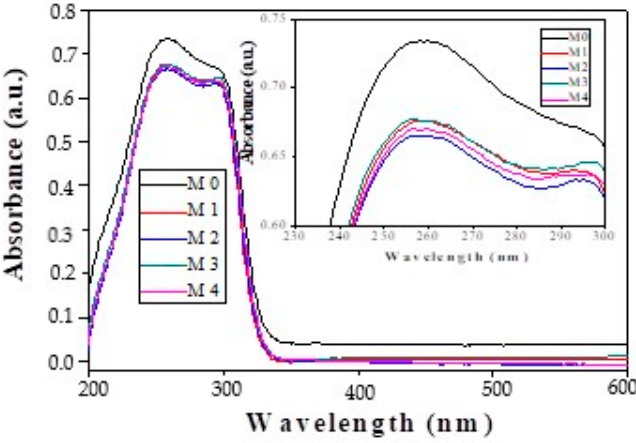
Figure 8. UV–VIS absorption spectrum of PPEES and nanocomposite membranes. The UV–VIS spectra show that PPEES polymer and polymer with silica nanoparticles, with different concentrations, exhibited similar absorption bands at 258 and 298 nm, indi- cating that the center of absorption bands is related to intramolecular and